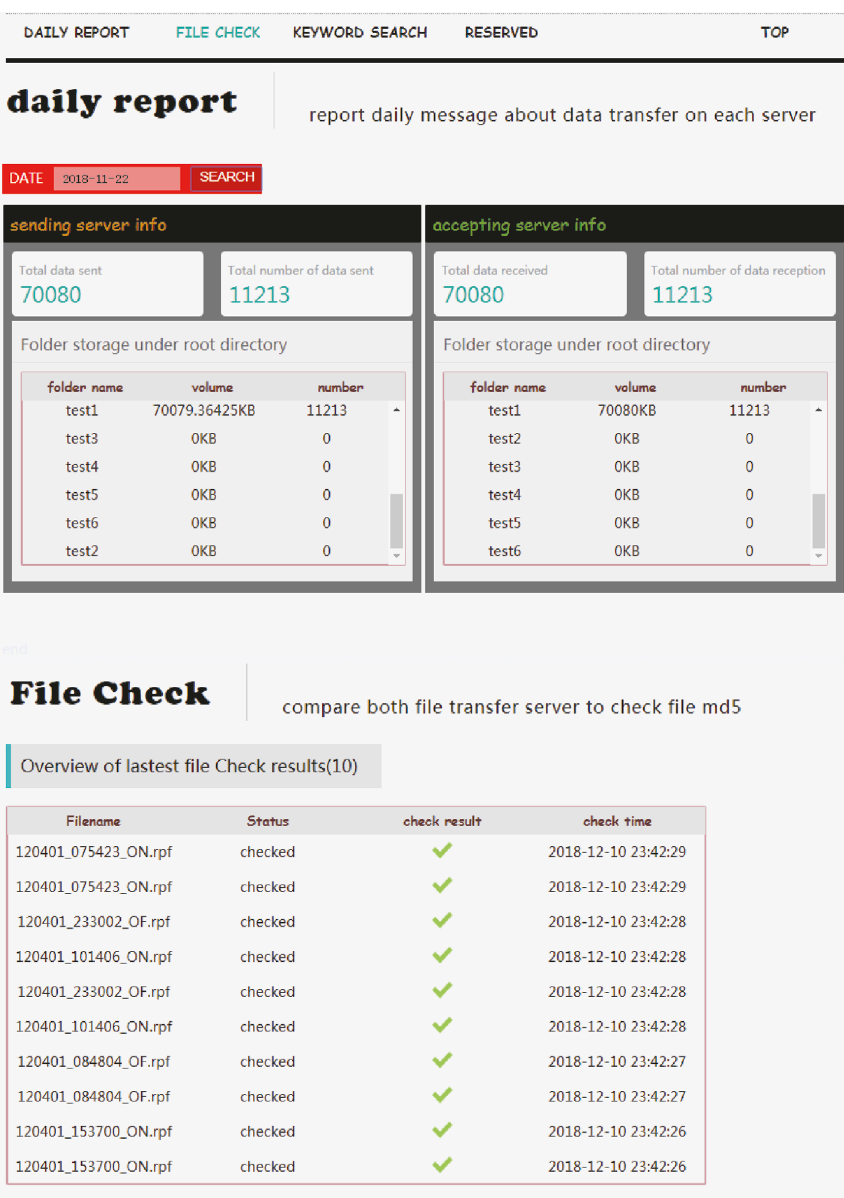
Figure 14: The advanced query